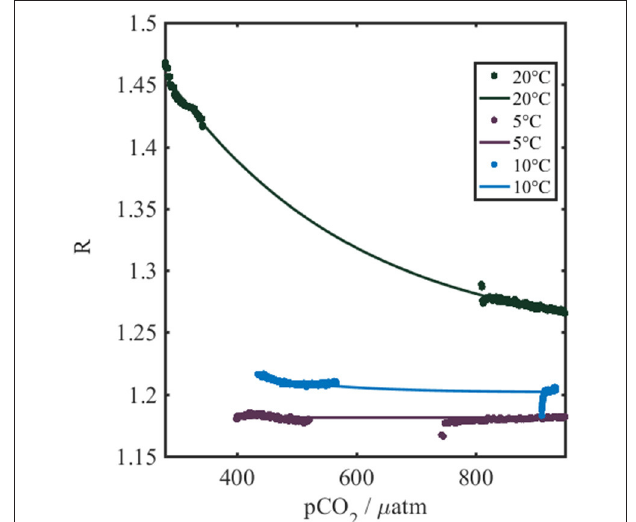
FIGURE 3 | Temperature dependence of the sensor spot output (R) measured using the gas calibration rig described in section Dissolved Gas Calibration Rig. Colored dots represent the actual collected data, while the thin colored lines are the best fits to the data. The colors indicate the water temperature during the calibration. The pCO 2 refers to pCO 2 - calcpH